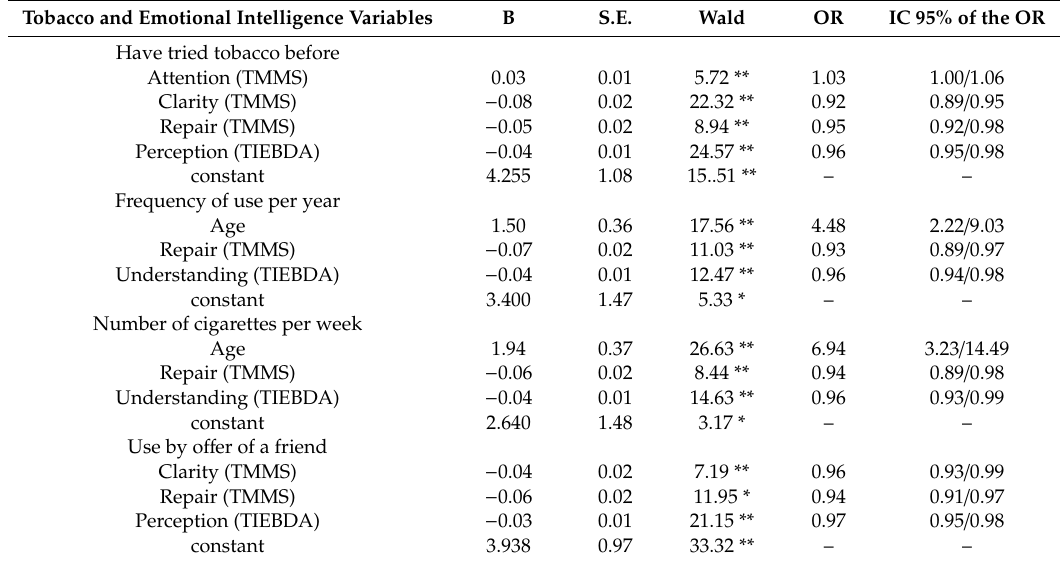
Table 3. Binary Logistic Regression of Tobacco Use as a Function of Trait and Ability EI. Tobacco and Emotional Intelligence Variables B